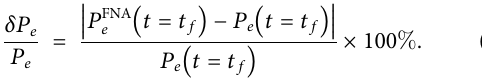
( t (cid:2) t ) is shown in f e